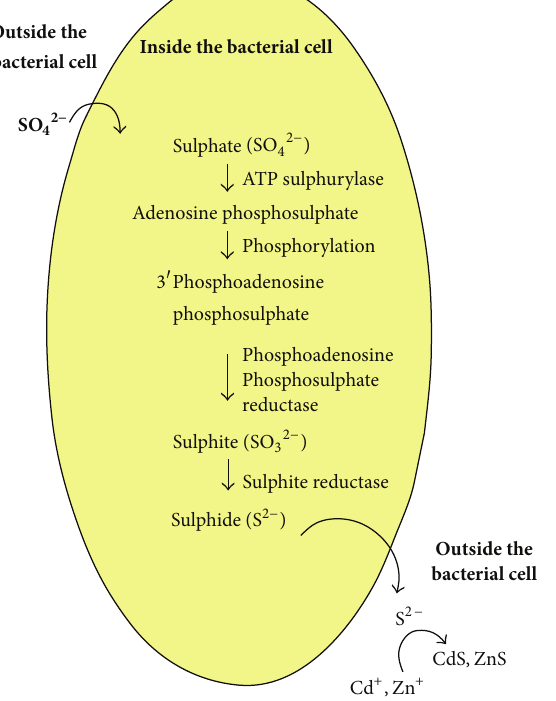
Figure 6: Probable pathway of biosynthesis and stability of biofunc- tionalized sulfide